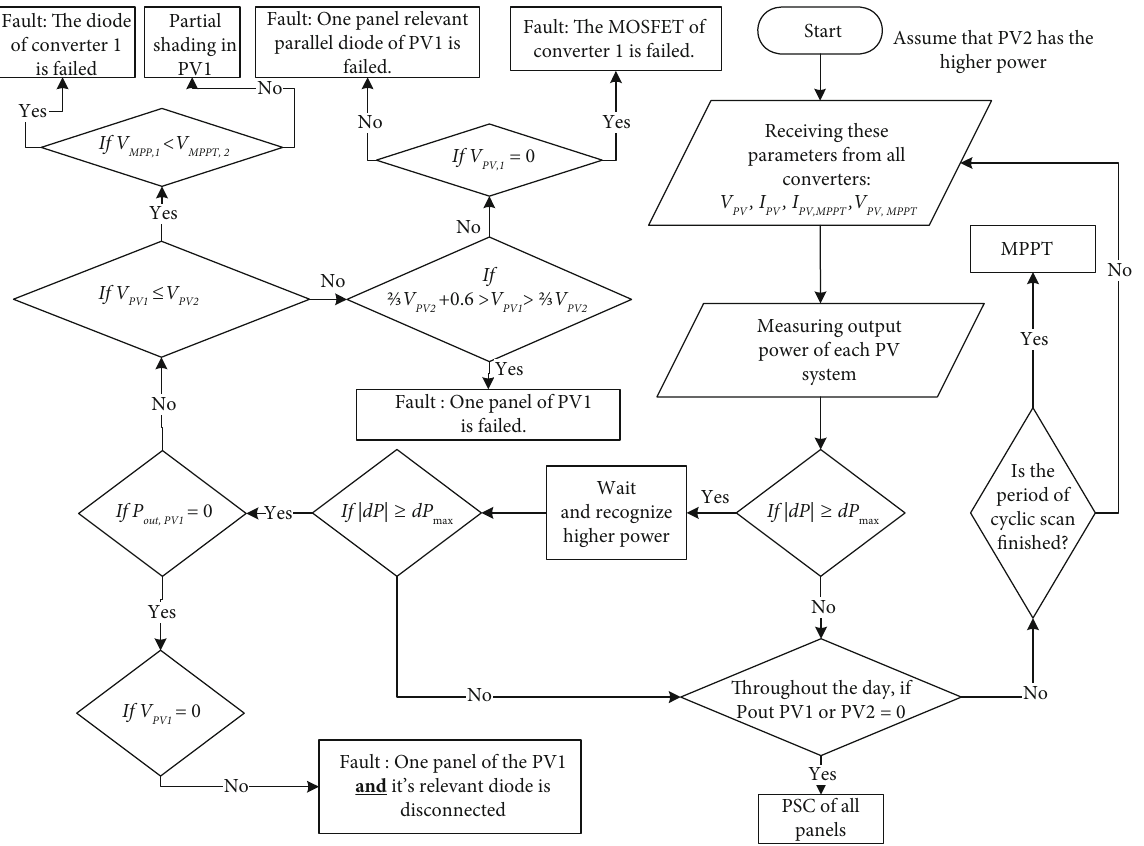
Figure 7: Flowchart of the proposed